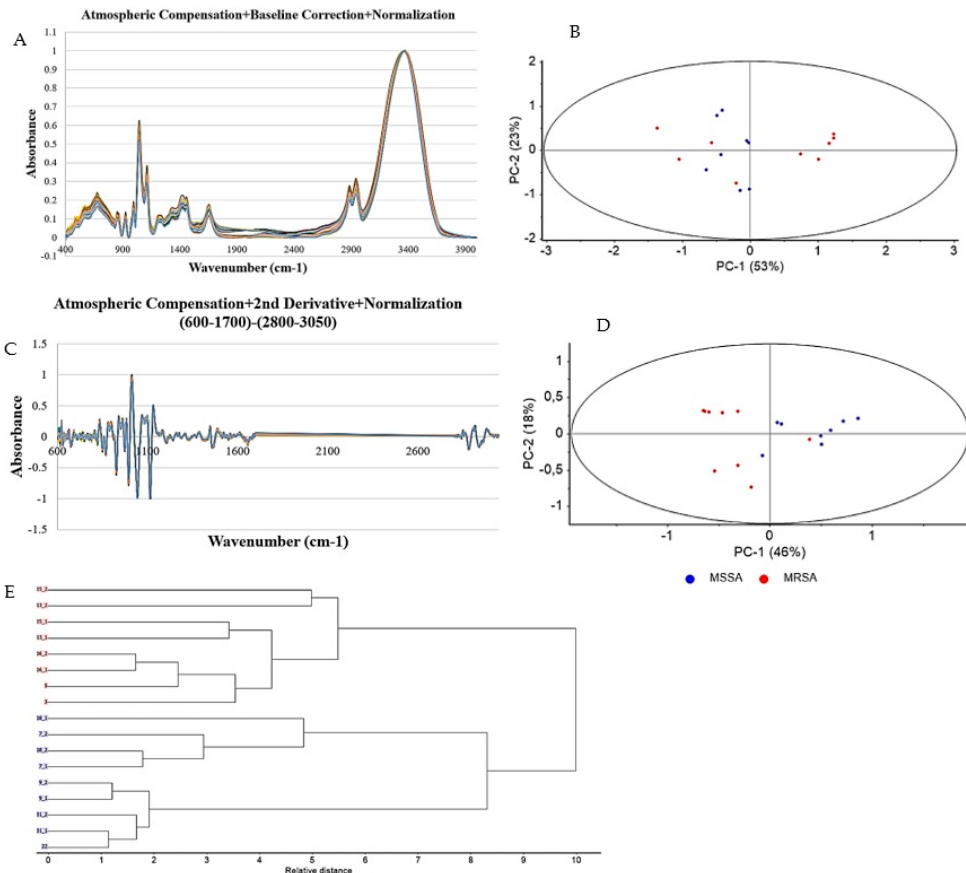
Figure 1. FTIR spectra after baseline and atmospheric correction and normalization ( A ) or normalized second-derivative spectra over ( C ) and its corresponding PCA ( B , D ), respectively. The dendrogram from HCA was based on normalized second-derivative spectra ( E ).